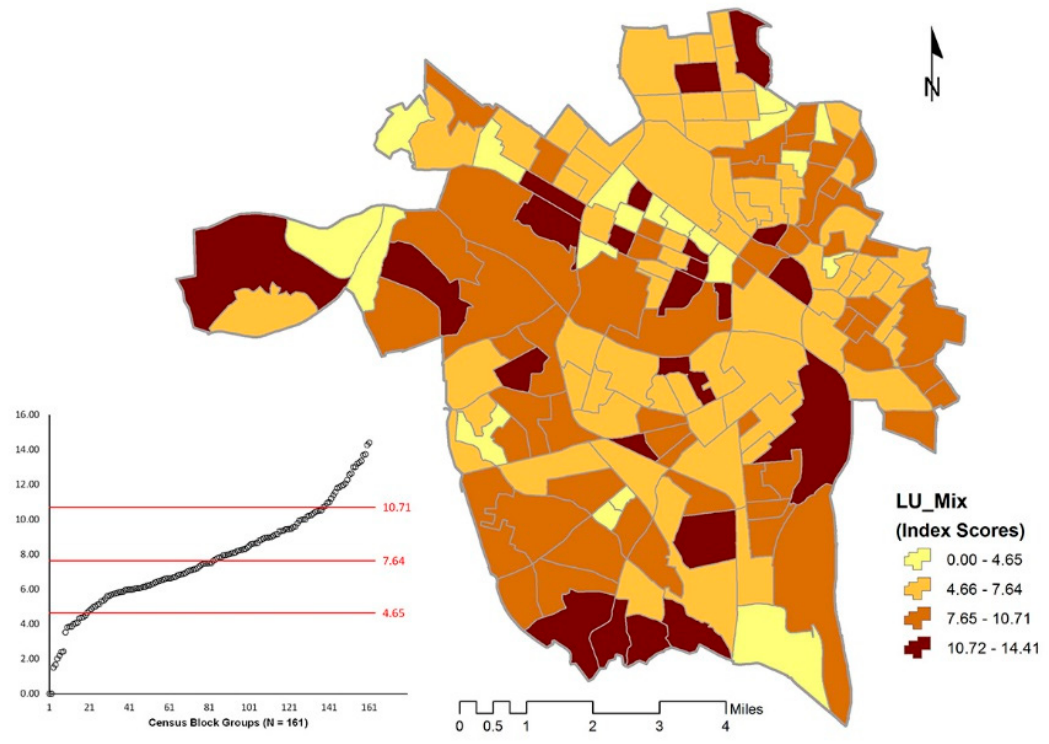
Figure 7. Land use mix of Census Block Groups in the City of Richmond.